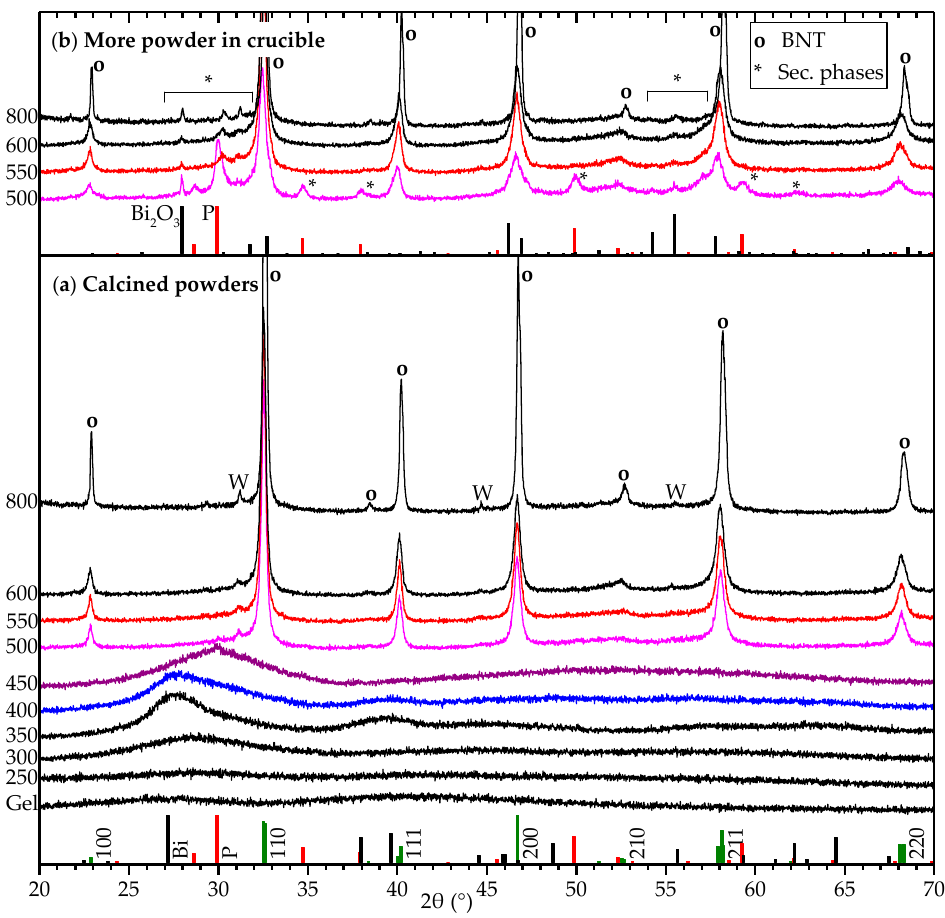
Figure 3. ( a ) XRD patterns of BNT powders calcined for 2 h in ambient atmosphere. The temperature interval 400–550 °C is color coded to augment comparisons between figures. Reference patterns are shown for R3c BNT (pseudo cubic hkl indices) [30], metallic bismuth (“Bi”), a Na-deficient pyrochlore phase (“P”) [31] and Bi 2 O 3 . Reflections denoted by W are caused by tungsten L α 1 radiation from the instrument. Rietveld refinement of the patterns are presented in Table A1, showing reasonable agreement with literature data [30]; ( b ) Powders calcined simultaneously as in ( a ), but with larger amounts of powder in the